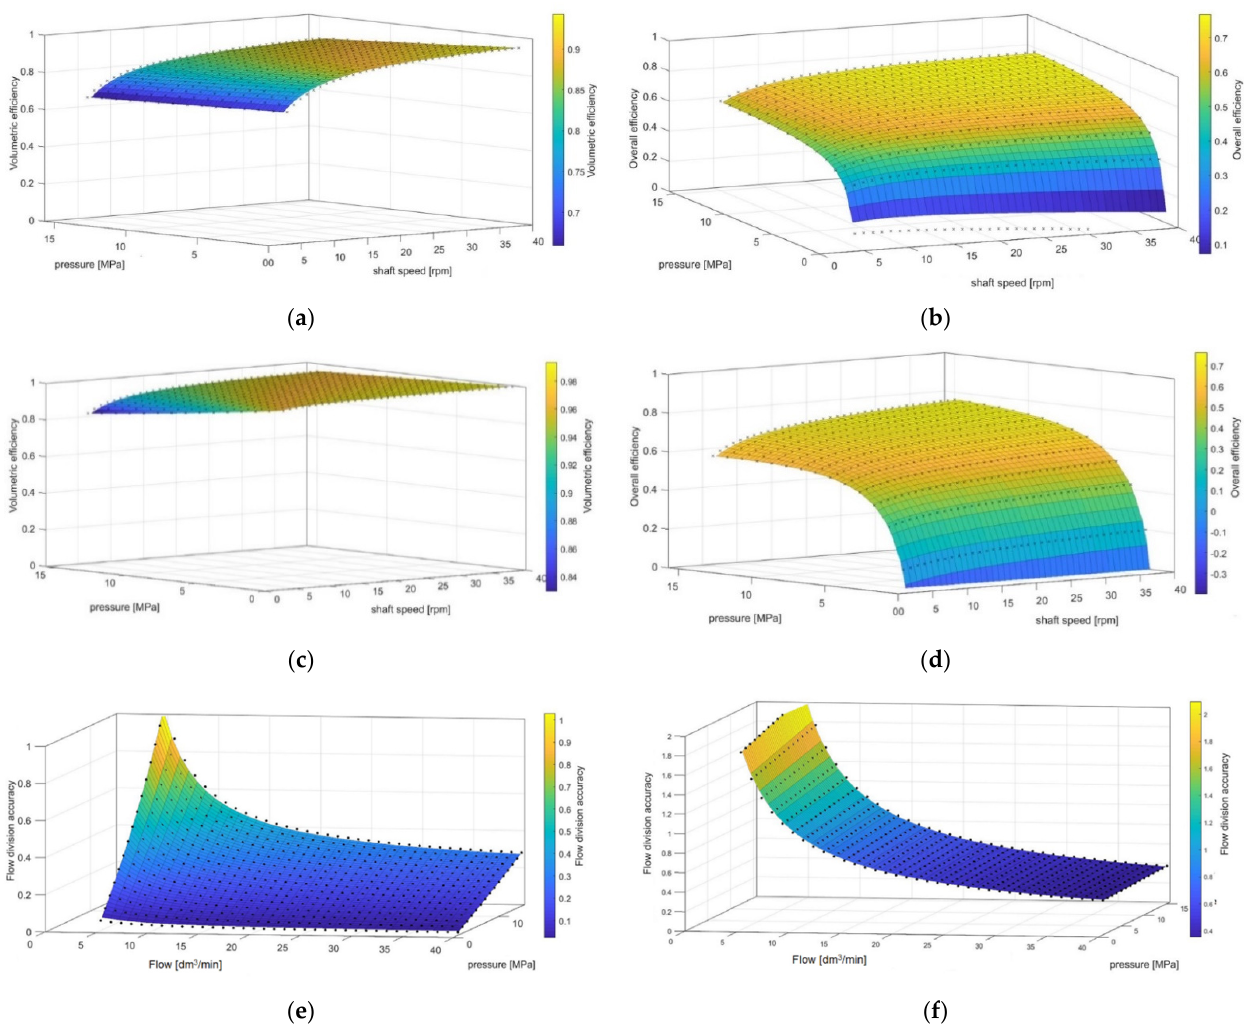
Figure 11. Characteristics of the hydraulic orbital motor volumetric ( a ) and overall ( b ) efficiency, radial piston motor volumetric ( c ) and overall ( d ) efficiency, and spool ( e ) and gear-type ( f ) flow divider’s dividing accuracy [17].